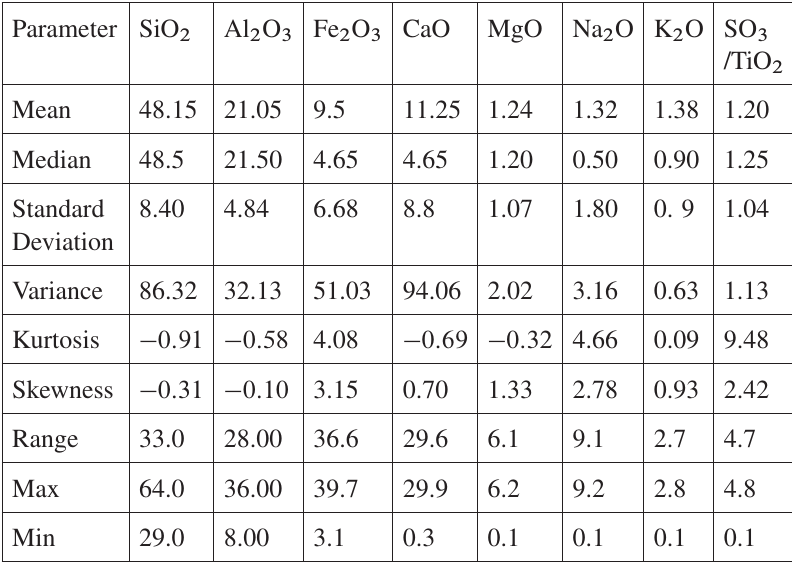
Table 2. Statistical details of data